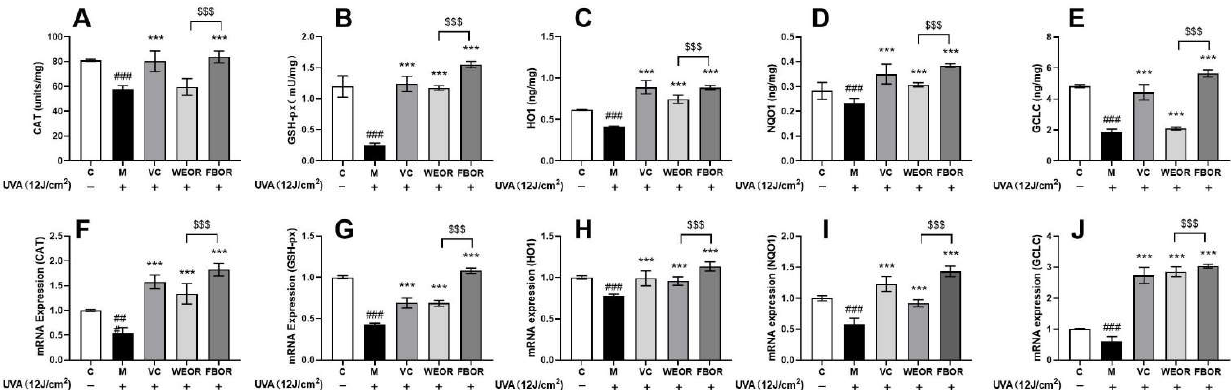
Figure 5. The effect of WEOR and FBOR on the level of antioxidant enzyme activity in HDF after UVA irradiation: ( A , F ) CAT activity and mRNA relative expression; ( B , G ) GSH-Px activity and mRNA relative expression; ( C , H ) HO-1 activity and mRNA relative expression; ( D , I ) NQO1 activity and mRNA relative expression; ( E , J ) GCLC activity and mRNA relative expression. (*** p < 0.001, versus the UVB irradiation model group; ## p < 0.01, ### p < 0.001, versus the control group. $$$ p < 0.001, the WEOR group versus the FBOR group. C: Control group; M: UVB irradiation model group).